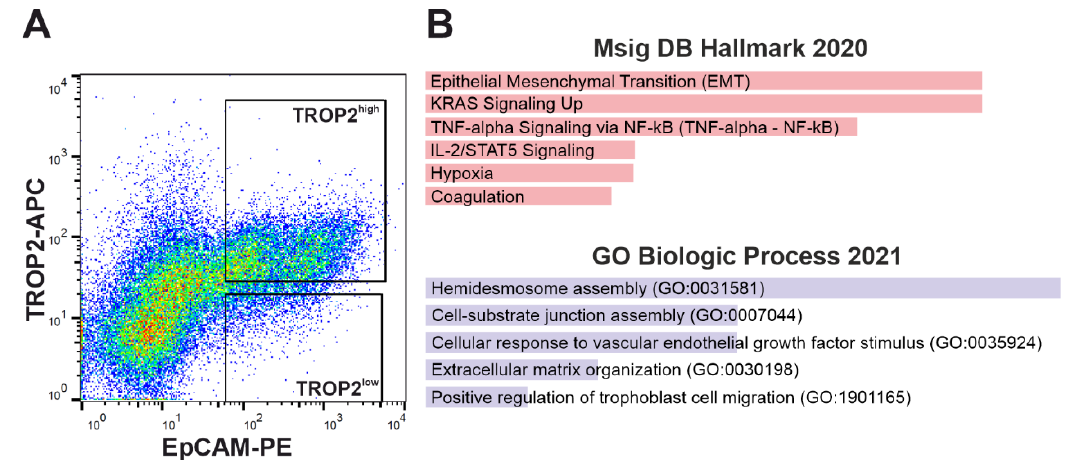
Figure 3. Analysis of human cells obtained from CRC specimens. ( A ) A representative diagram shows the fluorescence-activated cell-sorting gate used to obtain TROP2 high and TROP2 low human colon tumor cells; see Materials and Methods for further details. ( B ) Analysis of gene expression profiles of TROP2 high human tumor cells. Differentially expressed genes ( n = 72) enriched in TROP2 high cells (significance criterion: adjusted p -value < 0.05) were analyzed using the Molecular Signatures Database (MSigDB) Hallmark 2020 and Gene Ontology (GO) Biological Processes 2021 gene set collections. The adjusted p -value (calculated from Fisher’s exact test) was assigned to each category; the top five categories with the adjusted p -value < 0.01 are shown. The lengths of the columns correspond to the significance of each column in the graph — the longer the column, the higher the significance. The genes are listed in Supplementary Table S4.